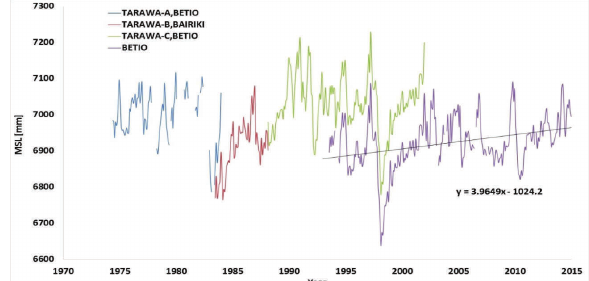
Fig. 1: Tide gauges in or nearby Betio Island in the Tarawa Atoll (data are from [8].